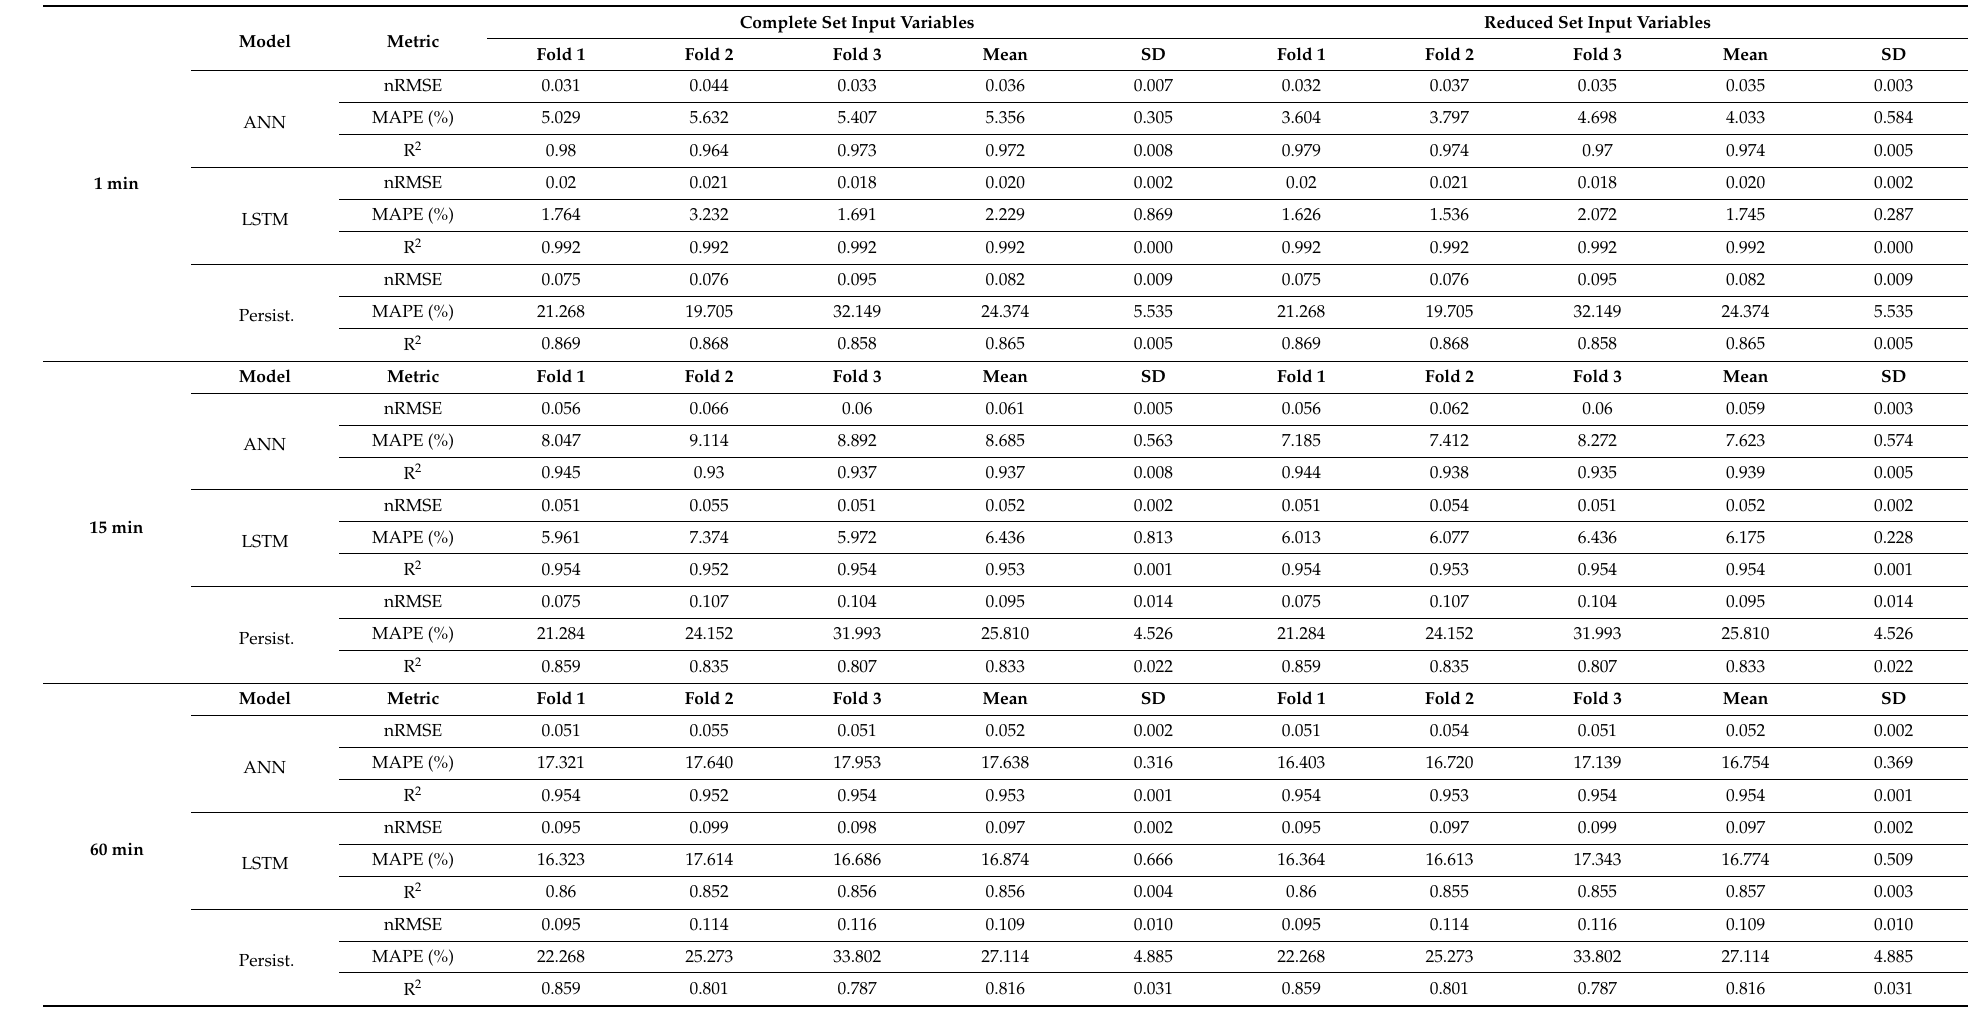
Table 6. Model accuracy metrics for all configurations of input set variables and horizon